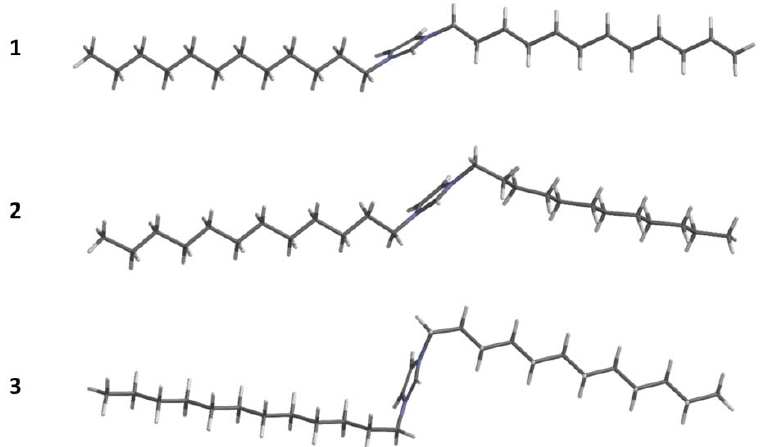
Figure 8. Density functional theory DFT optimized cation geometries: model with all ‐ trans chains ( 1 ), with gauche bond C1 ‐ C2 in the right chain ( 2 ), with gauche C1 ‐ C2 bond in both chains ( 3 ). Molecular axis is defined as a vector connecting terminal methyl carbons. Tilt angle ϕ of the imidazolium plane (cf. Figure 7b) is, respectively, 62°, 42°, and 22°. In all models, the C(2) ‐ H(2) vector makes an angle of ≈ 90° to the cation axis.